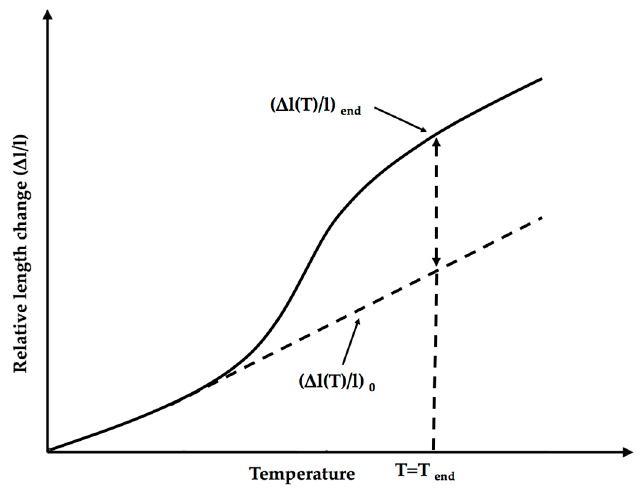
Figure 6. Relative length variations near the inflection point.